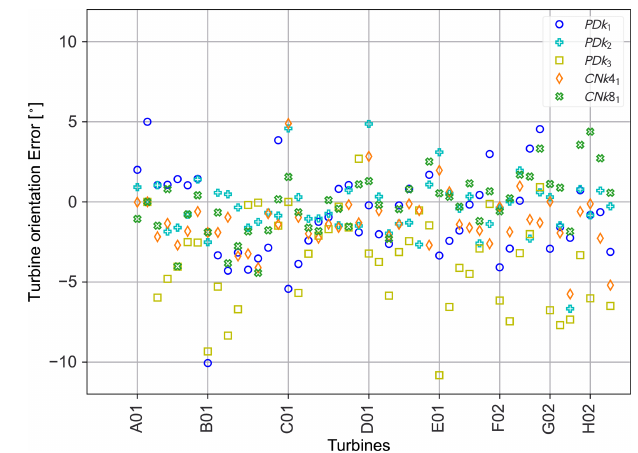
Figure 15. Errors between LES time-averaged wind direction at individual turbines and field SCADA measurements. All turbines in the LES domain face the wind and have zero yaw misalignment. Missing data points correspond to missing data.